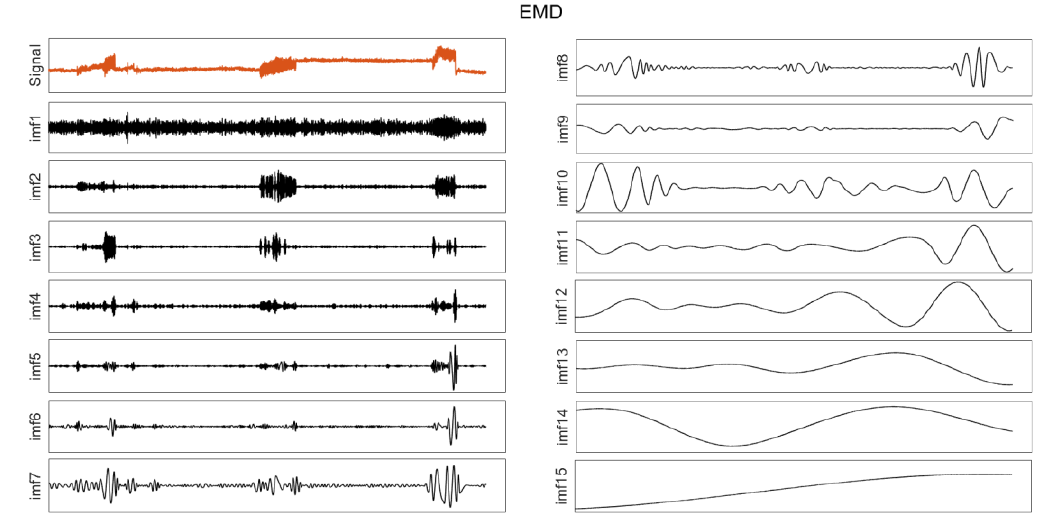
Figure 13. The EMD result of GNSS.